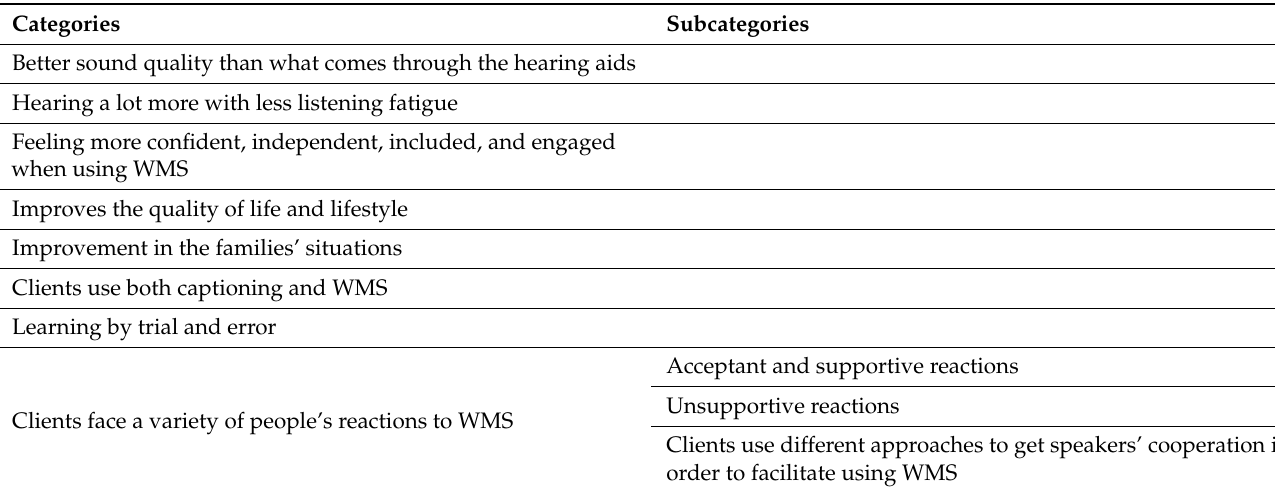
Table 4. Theme 3. Clients’ experiences using